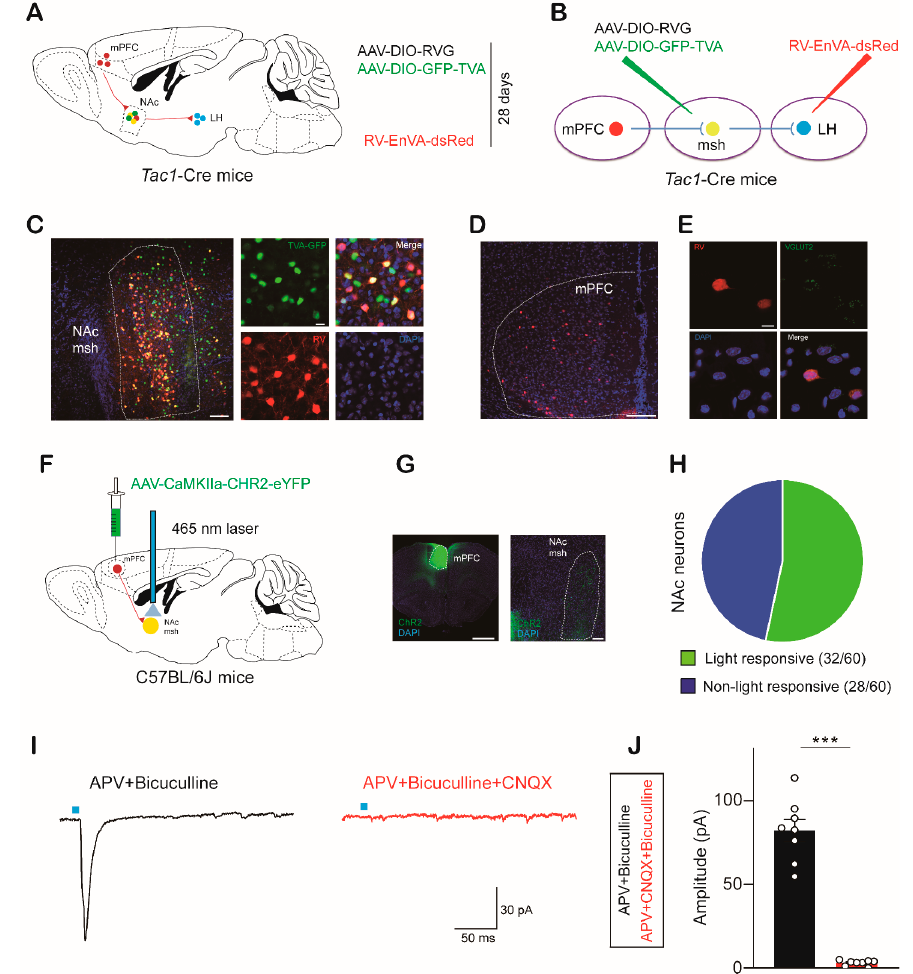
Figure 4. Monosynaptic viral tracing identifies the inputs of LH-projecting NAc Tac1 neurons: ( A , B ) Schematic of rabies-based cell type-specific monosynaptic tracing procedure. ( C ) Representative images showing NAc Tac1 starter cells (blue: DAPI; red: RV-ENVA- ∆ G-dsRed; green: AAV-EF1 α -DIO-EGFP-TVA. Scale bar: 100 µ m and 20 µ m, respectively. ( D ) Representative images showing a substantial rabies-deRed signal from LH-projecting NAc Tac1 neurons in the mPFC. Scale bar: 200 µ m and 20 µ m, respectively. ( E ) Representative mPFC image showing retrograde labeling in the mPFC from NAc msh Tac1 neurons, co-labeled with VGLUT2. (red: rabies-dsRed; green: VGLUT2; blue: DAPI. Scale bar: 10 µm). ( F ) Schematic of strategies used to express AAV-CaMKII α -ChR2-eYFP in C57 neurons. ( G ) Representative images of injection and projection sites. Scale bar: 1 mm and 100 µm, respectively. ( H ) Pie chart indicates that oEPSCs were recorded in 53% of cells (32 of 60 cells), and 47% were non-responsive in 5 mice. ( I ) The AMPA receptor antagonist CNQX totally inhibited oEPSCs in the NAc neurons induced by optical stimulation. ( J ) Average amplitude of oEPSCs rec- orded (two-tailed paired t -test, t 14 = 12.02, p < 0.0001). APV + Bicuculline: N = 3, n = 8; APV + CNQX + Bicuculline: N = 3, n = 8. N: animal number; n: cell number. mPFC: medial prefrontal cortex; NAc msh: nucleus accumbens medial shell; LH: lateral hypothalamic area. All data are means ± s.e.m. *** p < 0.001.